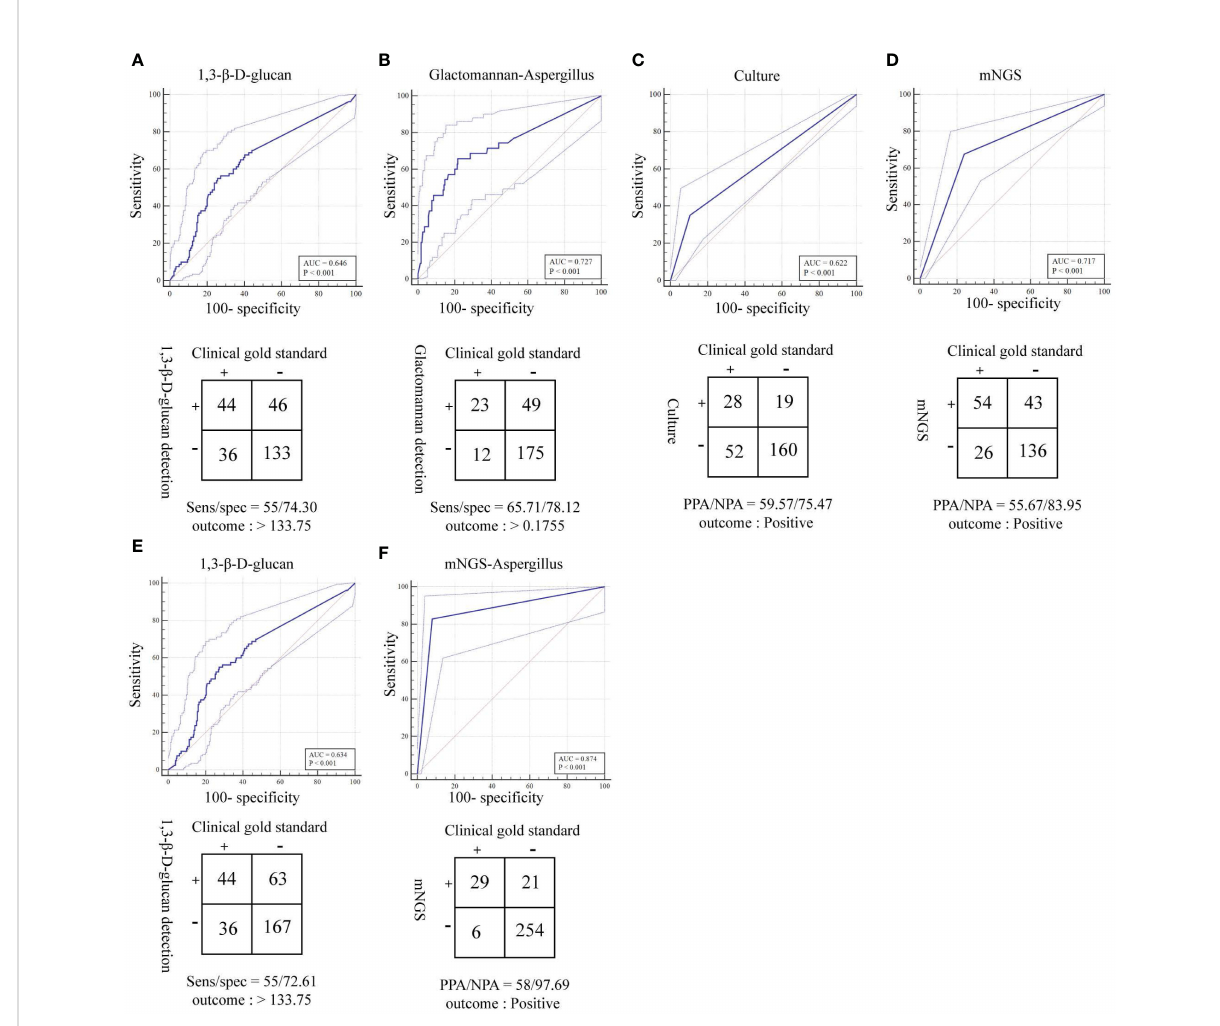
FIGURE 5 ROC curves and 2 × 2 contingency tables showing the respective diagnostic performance for different fungal detection methods; plotted are mNGS test sensitivities and speci fi cities, relative to the clinical gold standard. PPA and NPA are shown in lieu of sensitivity (sens) and speci fi city (spec), respectively, if a composite standard was used. (A) Diagnostic ef fi cacy of the 1,3- b -D glucan test (G test) for fungi (removal of patients with suspected Candida infection). (B) Diagnostic ef fi cacy of the galactomannan test (GM test) for Aspergillus. (C) Diagnostic ef fi cacy of the culture method for fungi. (D) Diagnostic ef fi cacy of mNGS for fungi. (E) Diagnostic ef fi cacy of the 1,3- b -D glucan test (G test) for fungi. (F) Diagnostic ef fi cacy of mNGS for